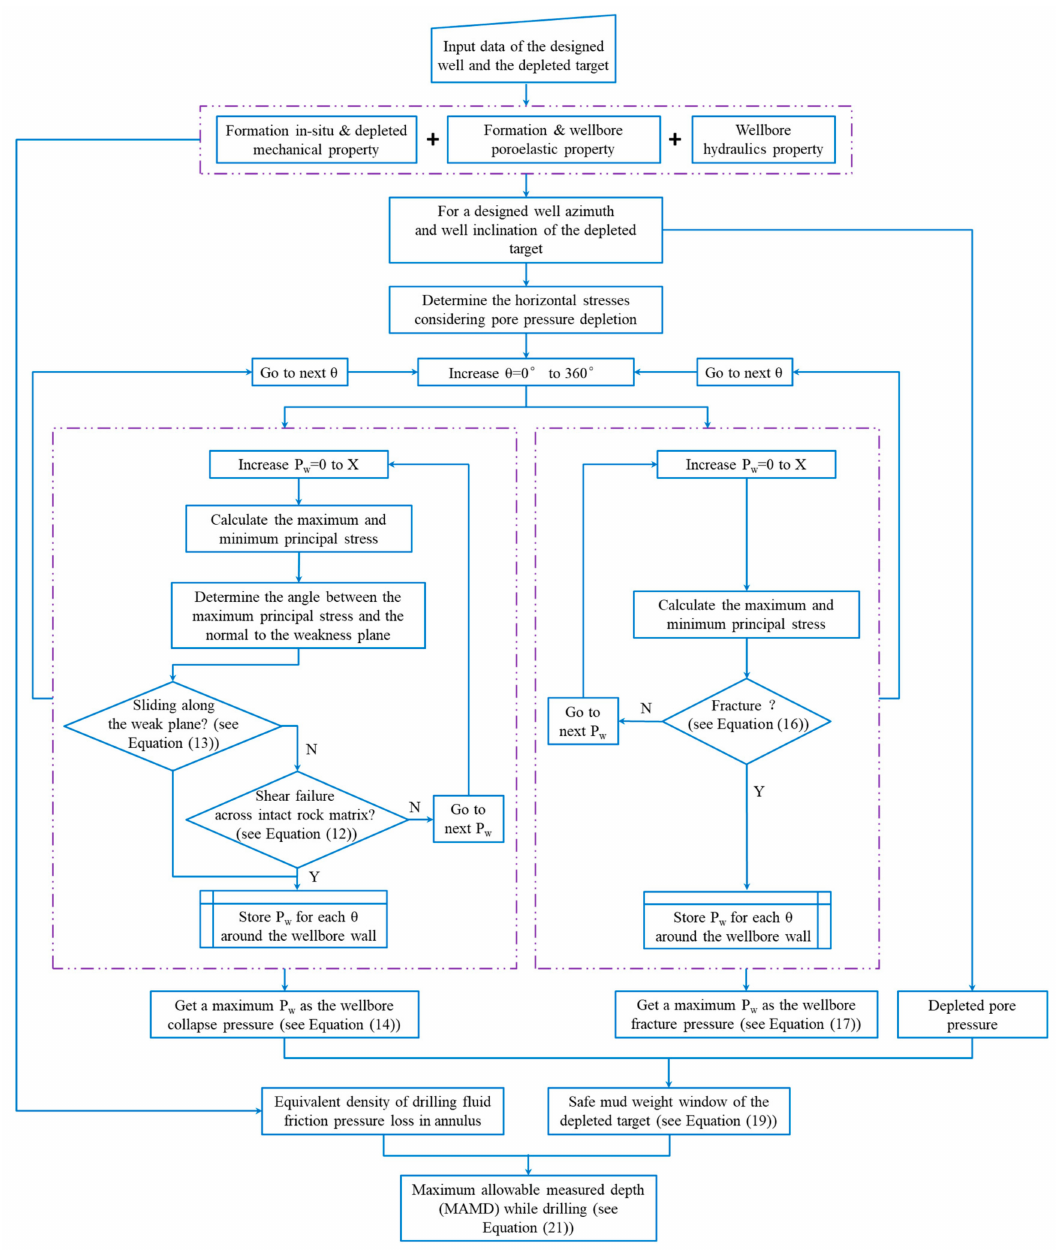
Figure 3. A flowchart for determining the